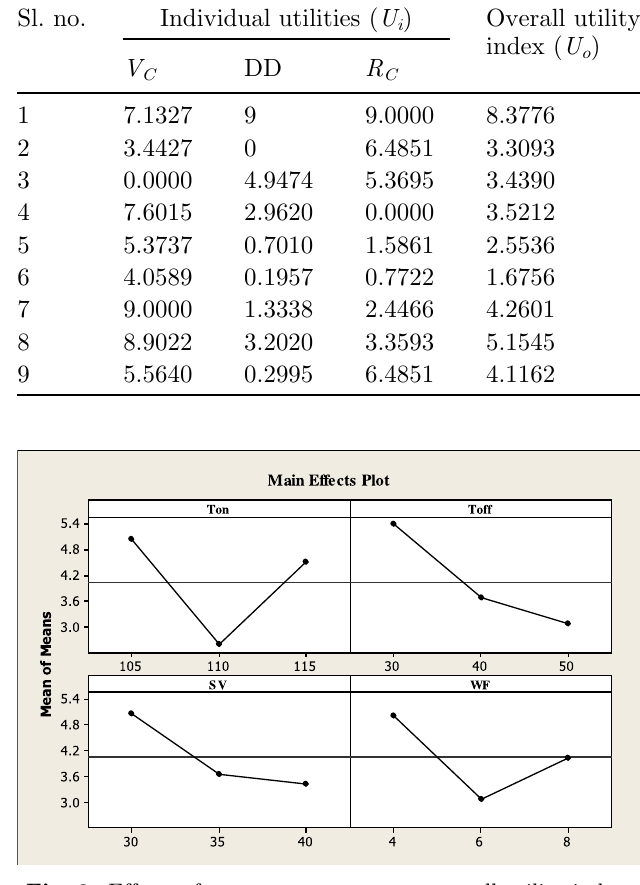
Fig. 3. Effects of process parameters on overall utility